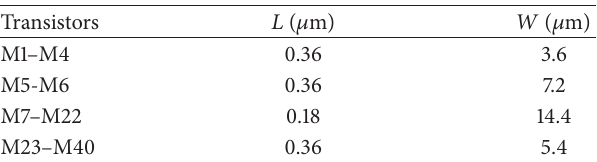
Table 2: The aspect ratios of the CMOS transistors in MO-DVCC